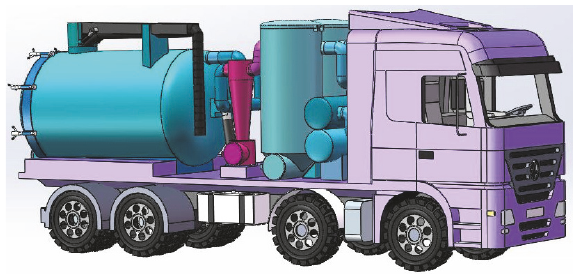
Figure 1: Hazardous materials collection